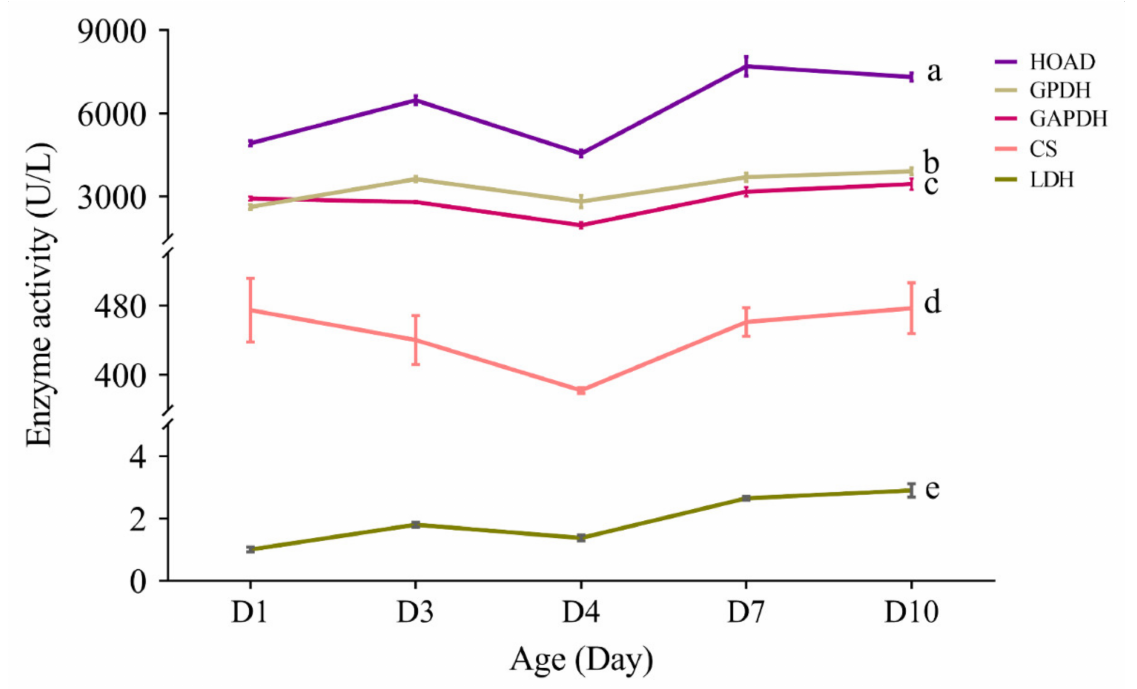
Figure 11. Activities of the five metabolic enzymes (GPDH, GAPDH, LDH, HOAD and CS) in the flight muscle of S. frugiperda females at different ages. Lines with different letters are significantly different ( p < 0.05). Error bars were ± SE.